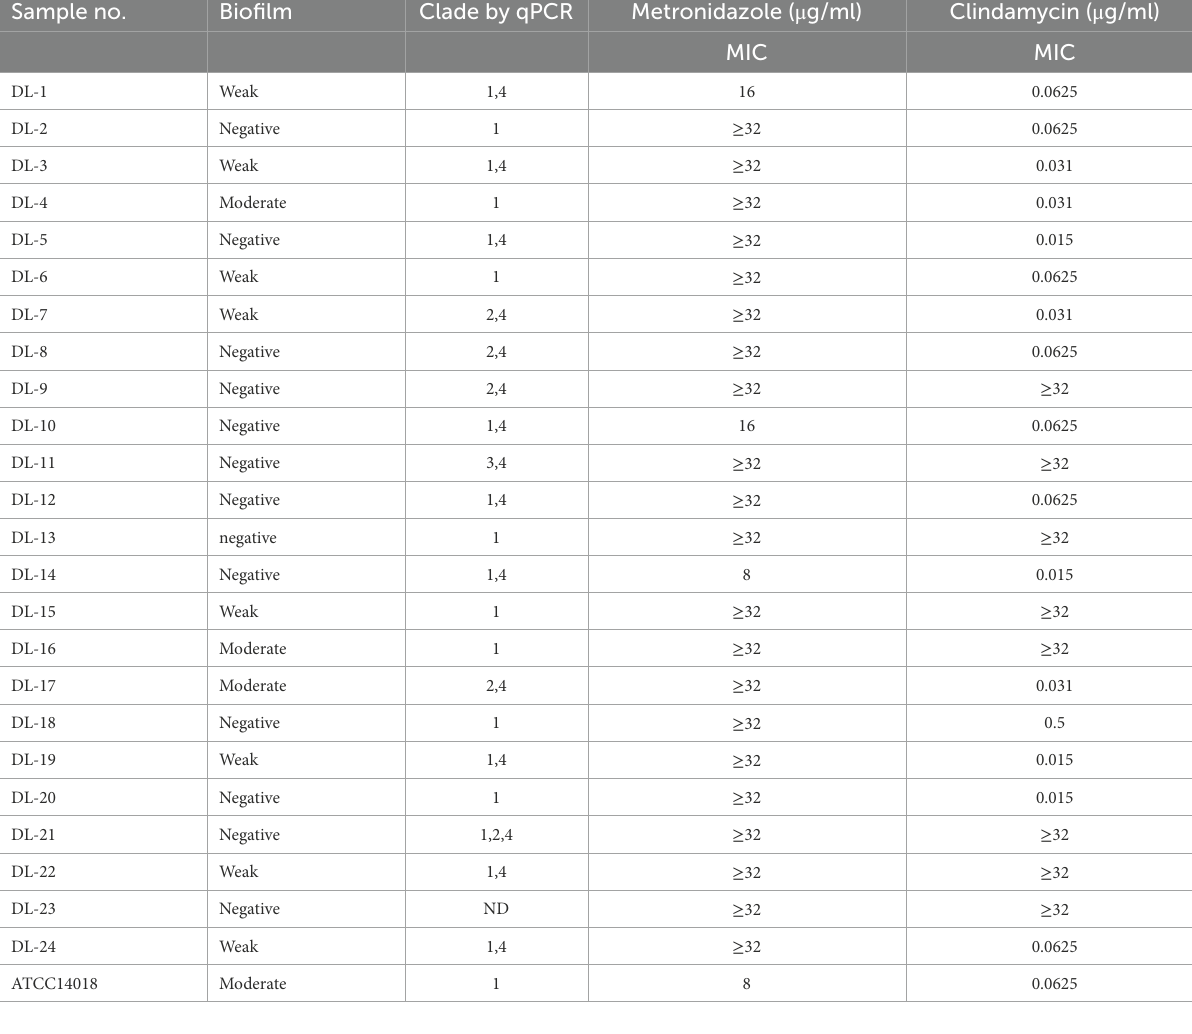
TABLE 1 Summary of antimicrobial sensitivity to G. vaginalis clinical samples grown as planktonic cells. Sample no.